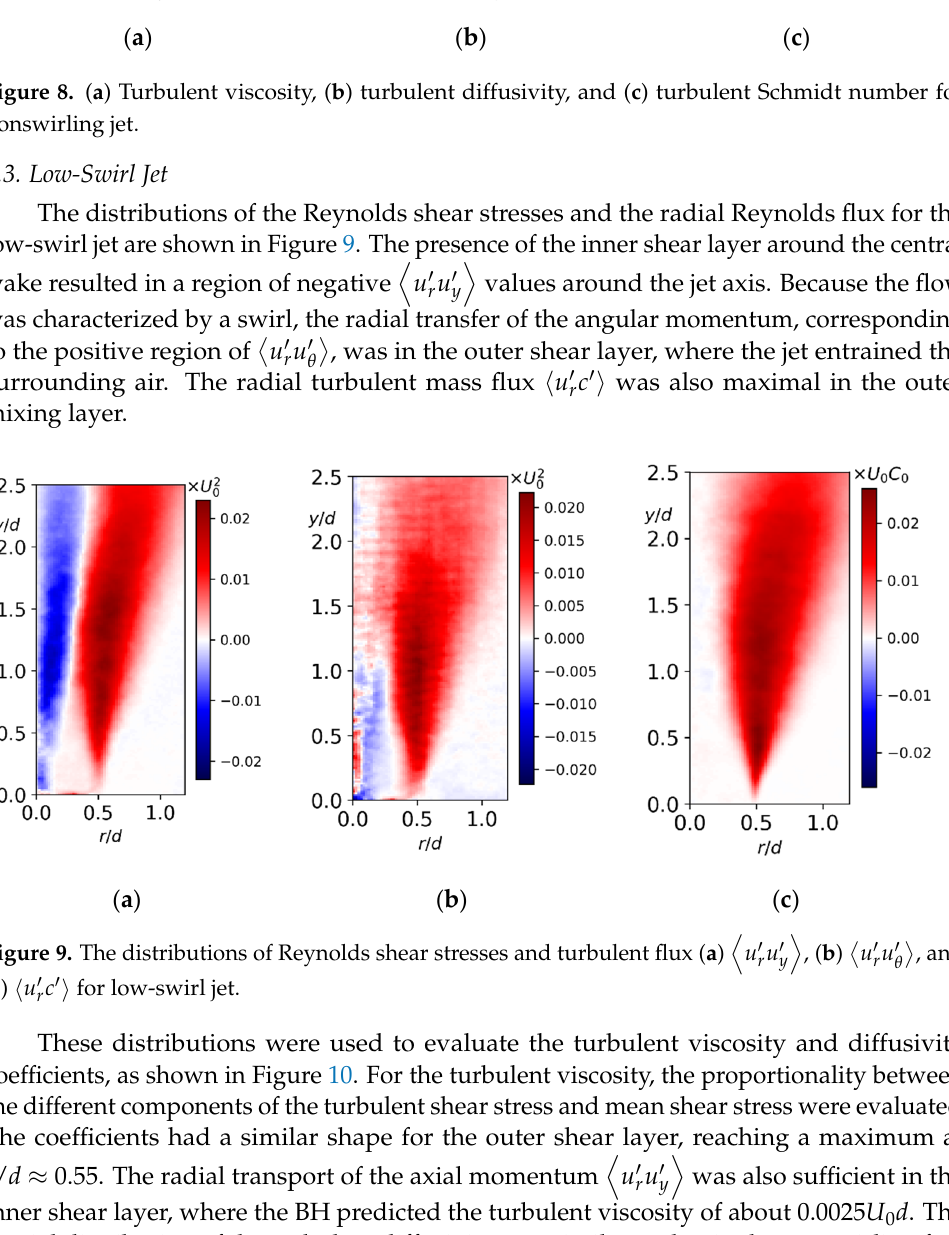
Figure 9. The distributions of Reynolds shear stresses and turbulent flux ( a ) ( c ) (cid:104) u (cid:48) r c (cid:48) (cid:105) for low-swirl jet.